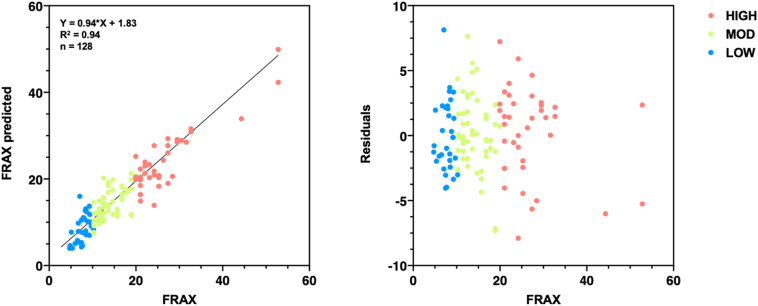
a) Plot of predicted FRAX versus actual FRAX score and b) residual of multiple linear regression performed using a two-way interaction model, including MRI parameters and demographic data.